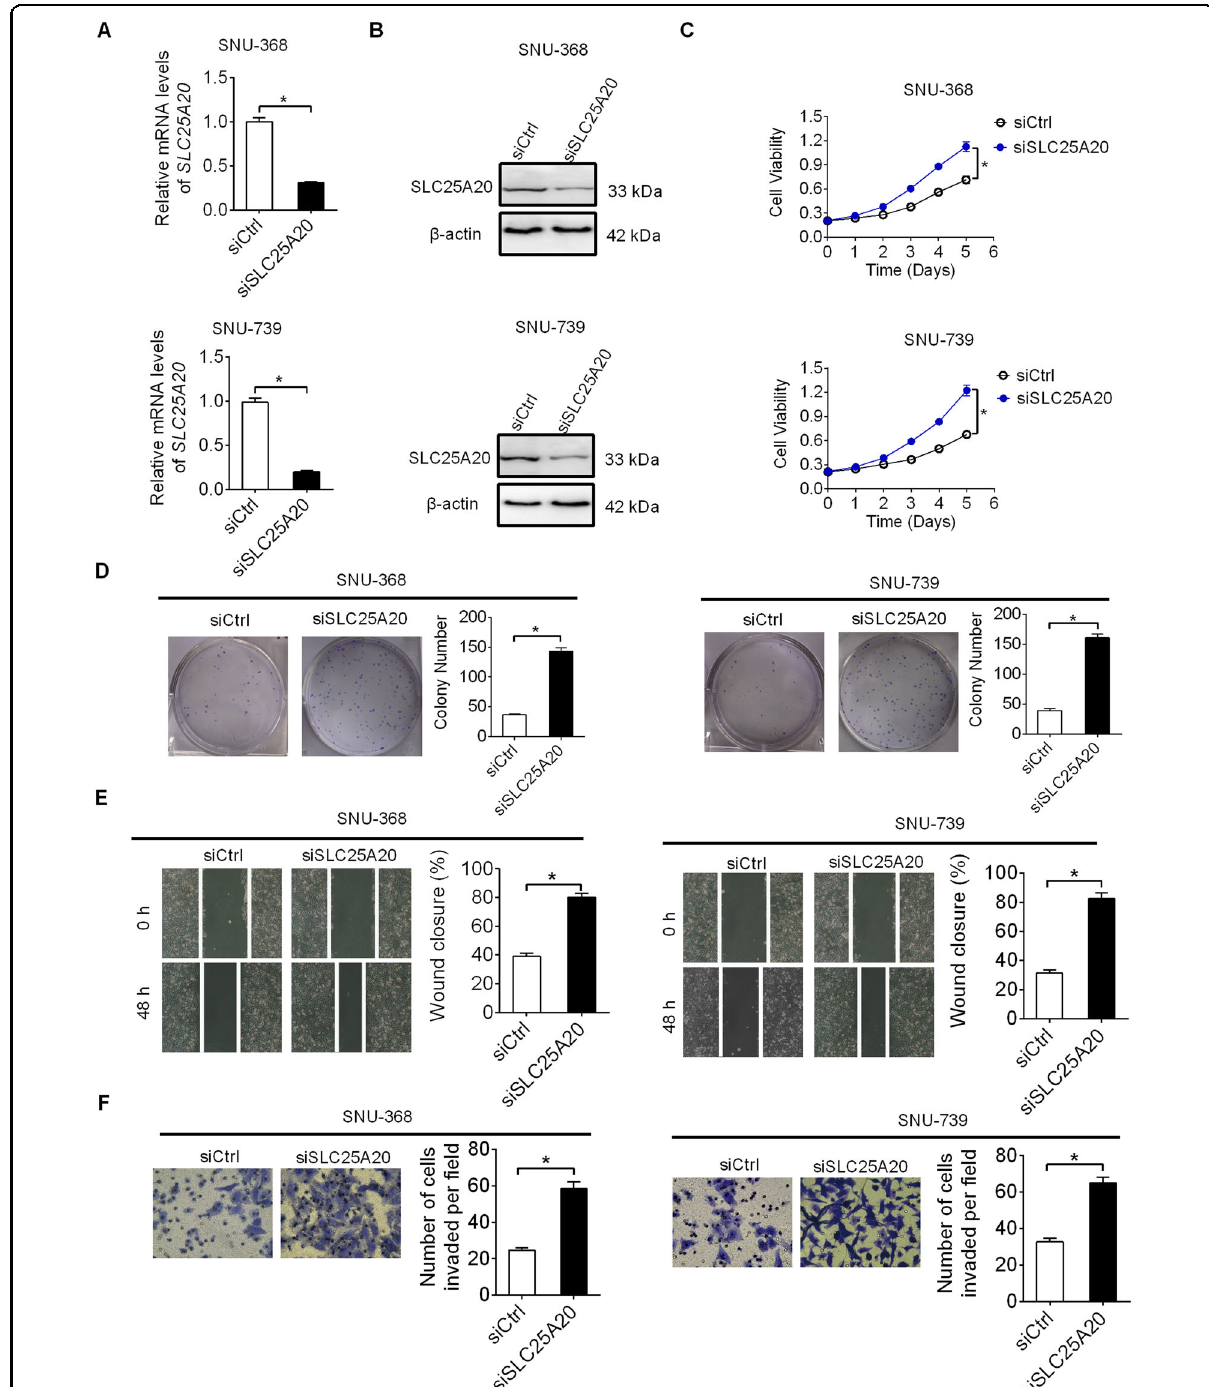
Fig. 5 Knockdown of SLC25A20 enhanced HCC cell growth and metastasis. A , B Knockdown of SLC25A20 was con fi rmed by qRT – PCR and Western blot analysis in SNU-368 and SNU-739 cells with treatment as indicated. (siSLC25A20, siRNA against SLC25A20; siCtrl, control siRNA). C , D MTS cell viability and colony formation assays were applied in SNU-368 and SNU-739 cells with treatment as indicated. E , F Wound-healing and matrigel- invasion assays were used for determination of cell metastasis in SNU-368 and SNU-739 cells with treatment as